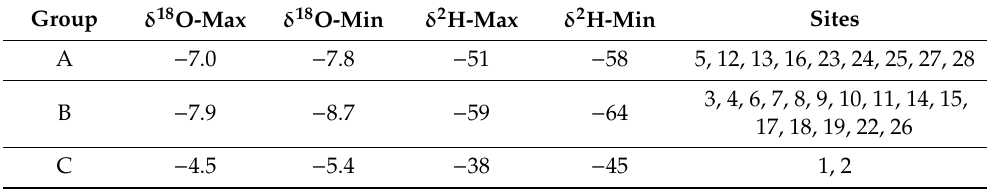
Table 2. Summary of maximum and minimum ( δ 18 O, δ 2 H) values for groups A, B, and C in Figure